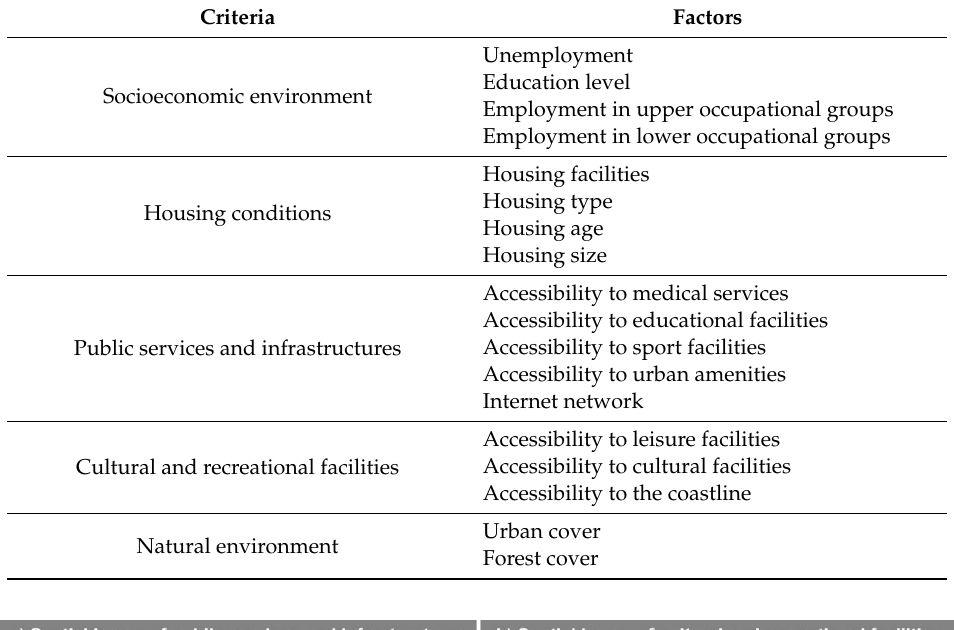
Table 2. Quality of life (QoL) criteria and factors.